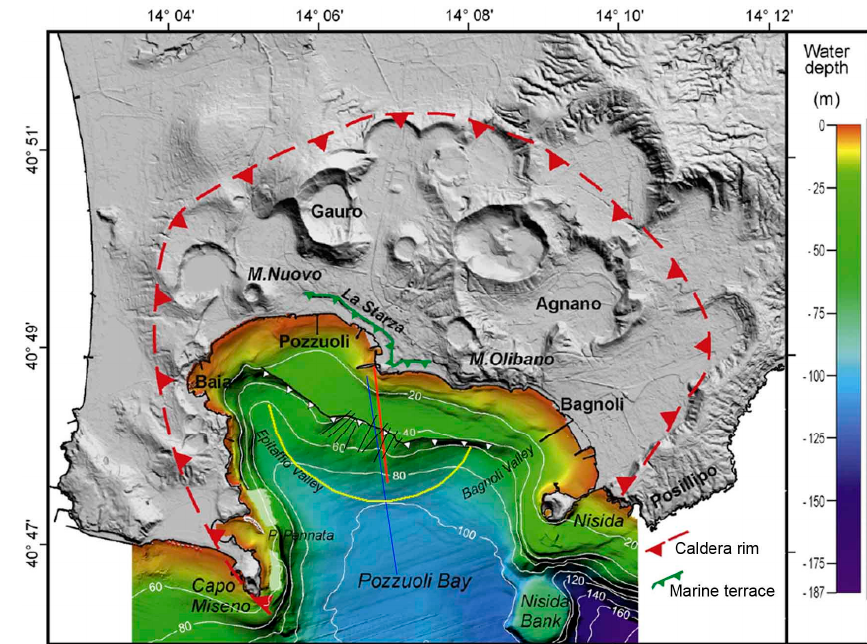
Figure 1. Main structures and morphological features of the onshore and offshore caldera of Campi Flegeri (after [24]). The solid red and yellow lines in the offshore area represent the trace of the fiber-optic cable and the southern limit of the doming zone, respectively. The blue line is the section of the seismic profile. Black lines in the offshore area represent the faulting zones of the apical dome (see text for details).